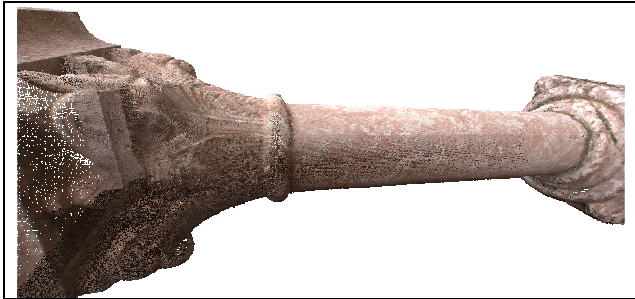
Figure 5. Exemple of column of Saint-Michel de Cuxa. modelized by architects of the lab Map-Gamsau using the interface to MicMac-Apero described in (Godet 2010).